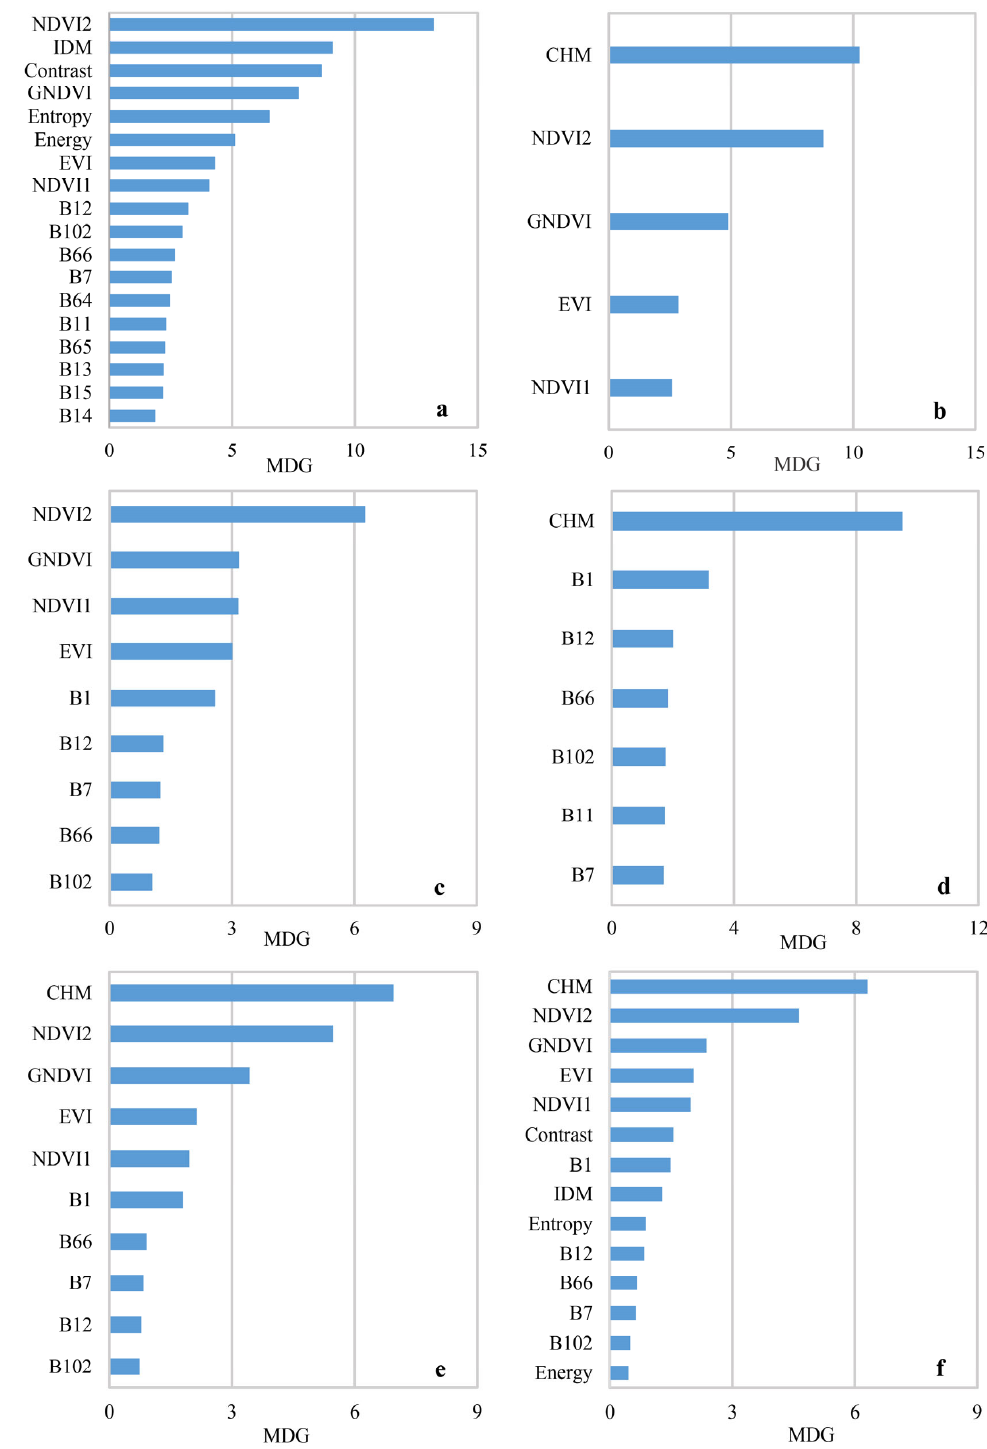
Figure 6. Variable importance ranking based on Mean Decrease Gini (MDG); ( a ) the variables’ importance ranking results of using spectral features (SF), vegetation indices (VI), and texture features (TF), separately; ( b ) the canopy height model (CHM) combined with VI; ( c ) VI combined with SF; ( d ) CHM combined with SF; ( e ) CHM combined with VI and SF; and ( f ) the combination of four types of variables. (Note: NDVI1: normalized difference vegetation index using a near-infrared short band; NDVI2: normalized difference vegetation index using a near-infrared long band; GNDVI: green normalized difference vegetation index; EVI: enhanced vegetation index; IDM: Inverse Differential Moment; Bx: the reflectance value on